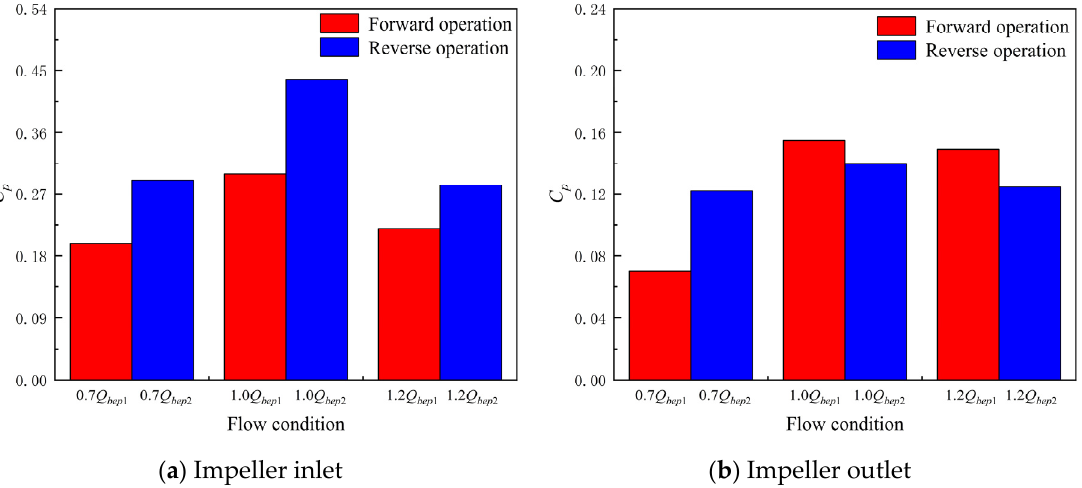
Figure 19. C p amplitude of main frequency at impeller inlet and impeller outlet of bidirectional axial flow pump under different operating conditions.